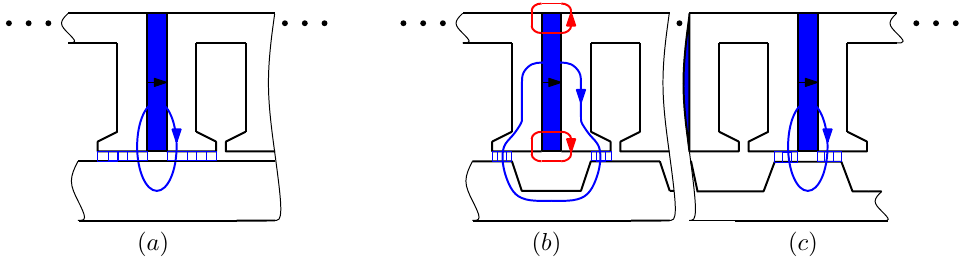
Figure 2. Flux tube surface in the air gap (hatched in blue). Legend: ( a ) Case of a slotless rotor, ( b ) position of minimum flux linkage (PM in the stator facing the middle of a slot in the rotor), ( c ) position of maximum flux linkage (PM in the stator facing the middle of a rotor